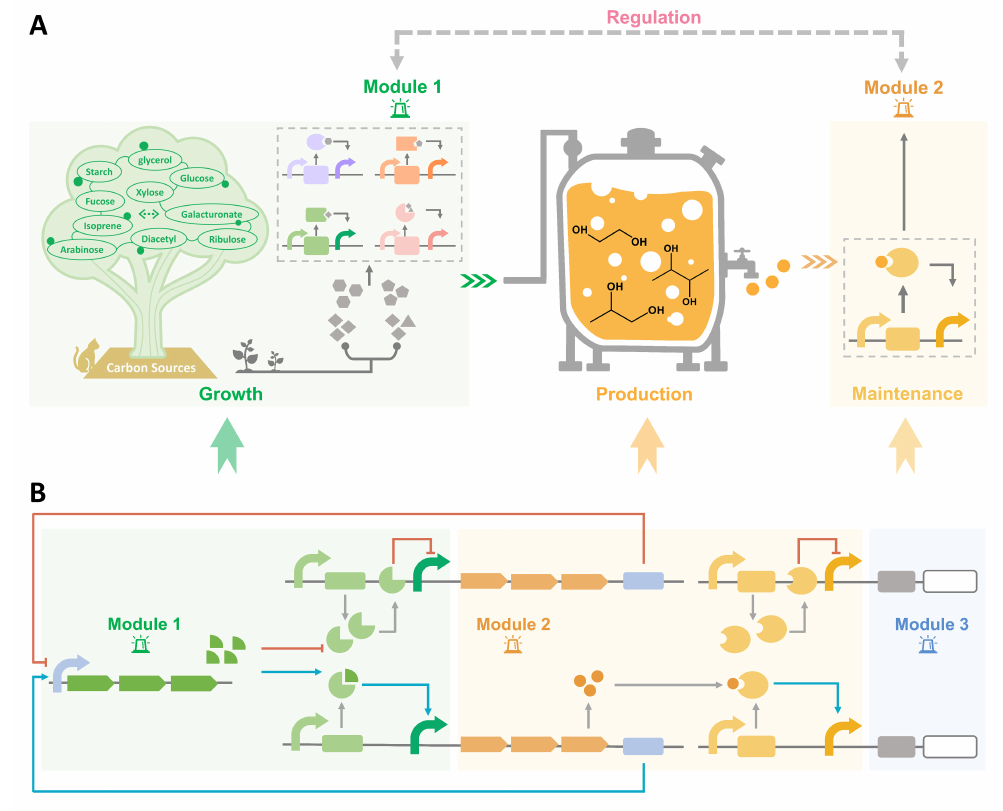
Figure 3. Dynamic regulation of diol production. ( A ) The regulation network between growth and diol production. The growth state and the production state are monitored in real time, and the balance is maintained in the host to achieve the high-level biosynthesis of diols. ( B ) Module design to dynamically regulate diol production. Module 1 detects the supplementation of carbon sources. Module 2 is responsible for the detection of diol yields. Module 3 is designed for controlling the flow of the metabolic